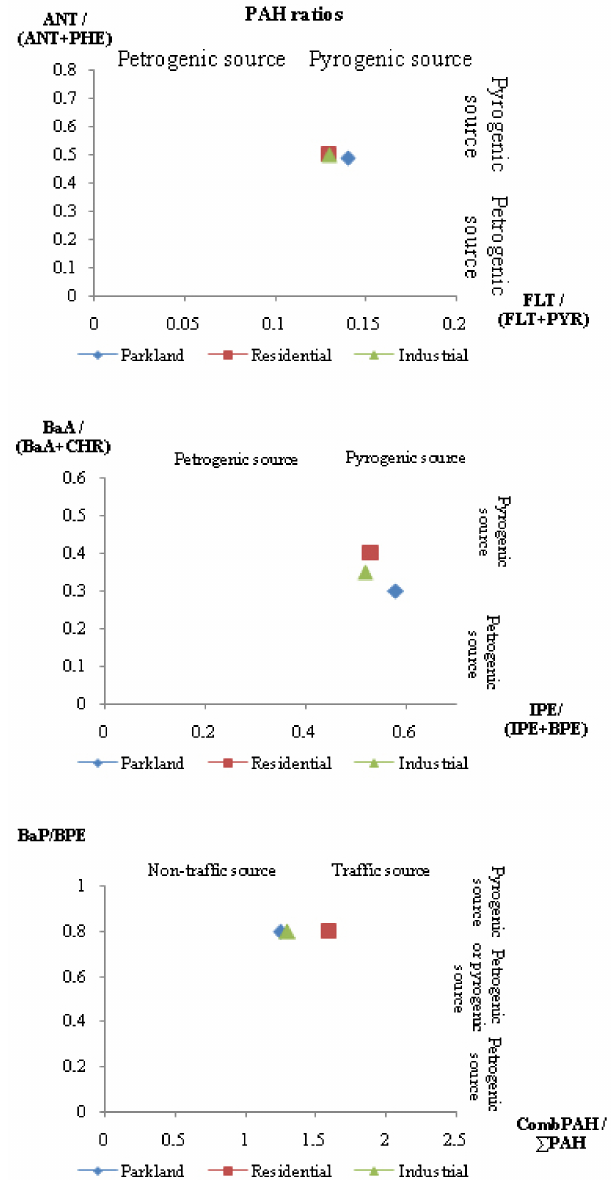
Figure 3. PAH source